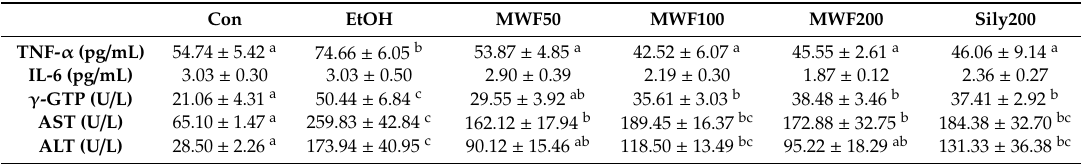
Table 2. E ff ects of MWF on the serum marker levels in chronic alcohol-fed rats. Con